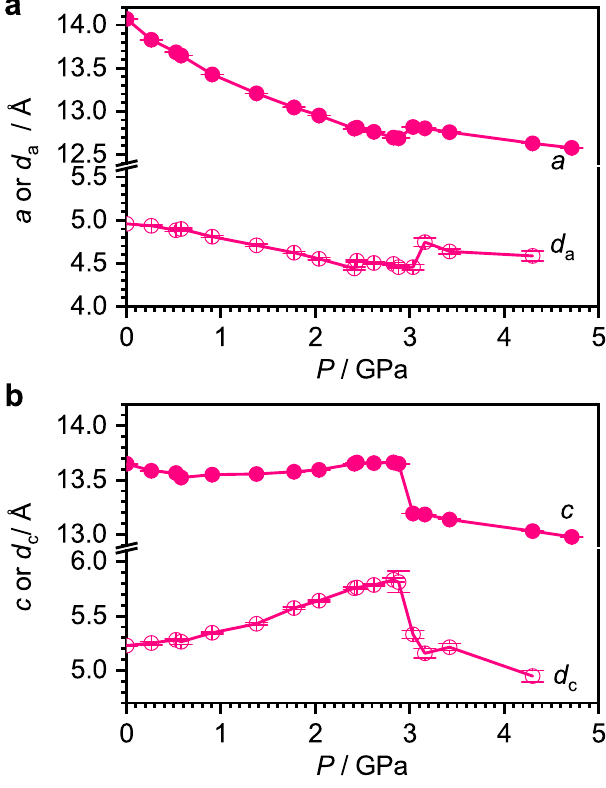
Fig. 3|Theeffectofpressureon selectedcrystallographicmetricsofTh(OAr) 4 . a Solidcircles:thelengthoftheunitcellparameter a (= b )asafunctionofpressure. Open circles: the projected contribution of the ThO 4 moiety to the a axis length. b Corresponding plots for the c axis. Similar plots for U(OAr) 4 and Np(OAr) 4 are available in Supplementary Figs. 8 and 9. Calculation of the projected dimensions and their error bars is explained in the Supplementary Information, Section